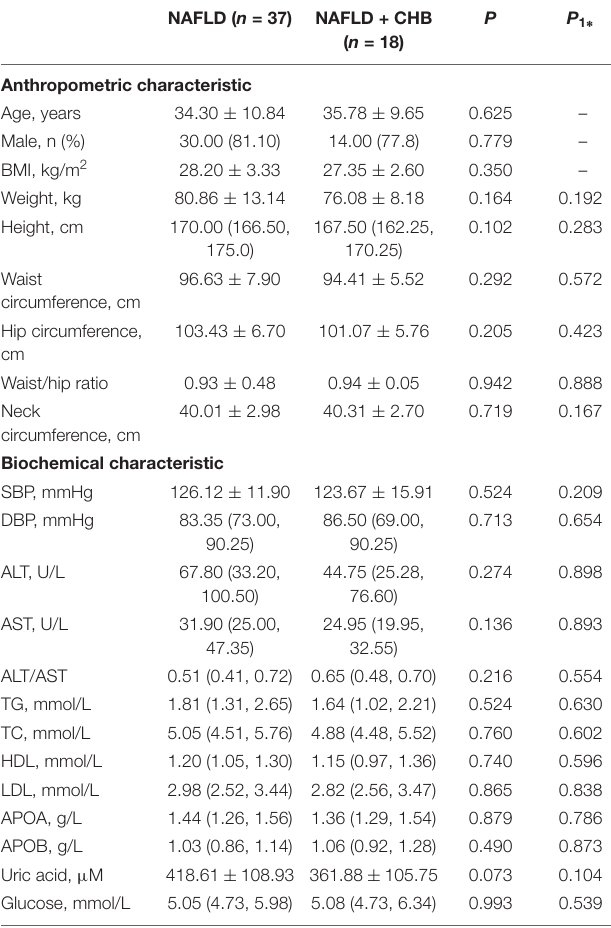
TABLE 1 | Anthropometric and biochemical characteristics of the study population based on the chronic hepatitis B